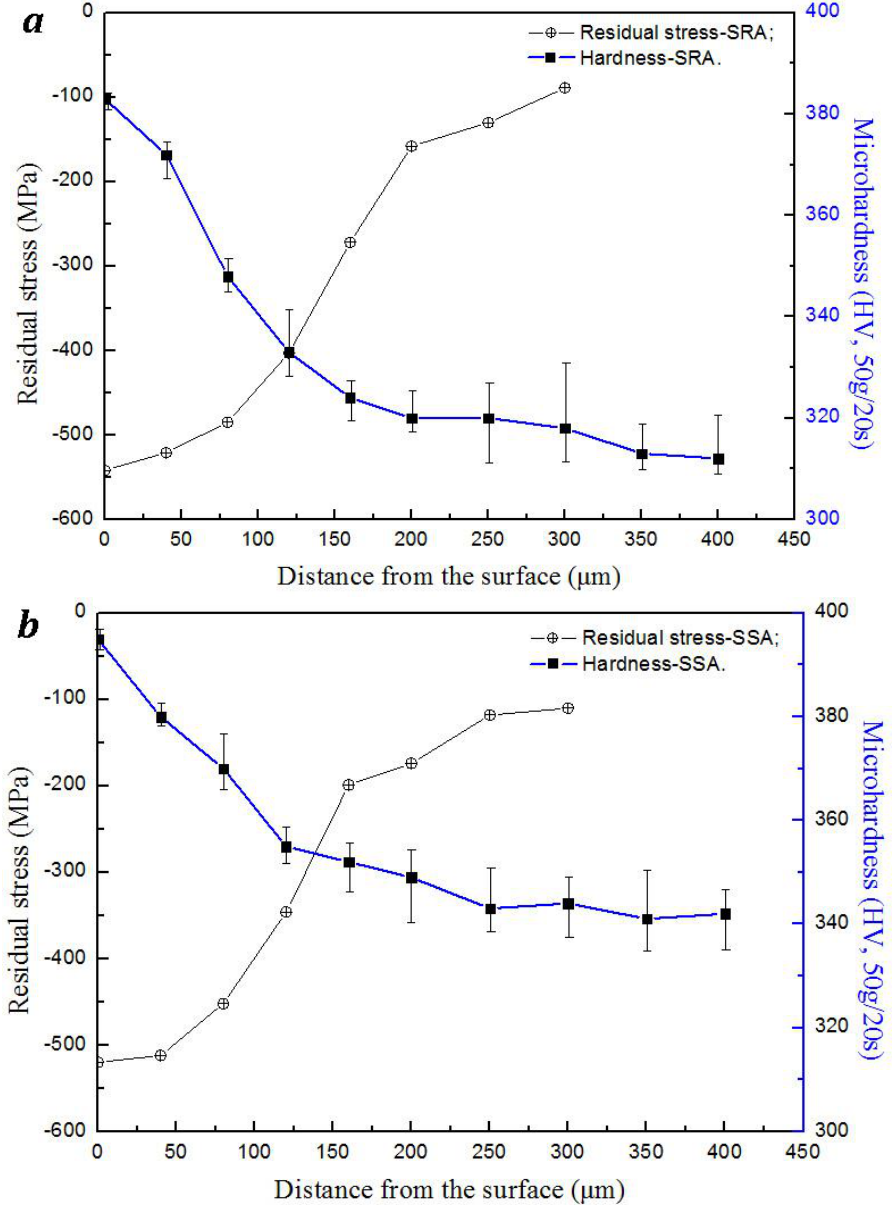
Figure 4. Variation of hardness and compressive residual stress of TC4 after UNSM: ( a ) SRA; ( b ) SSA.